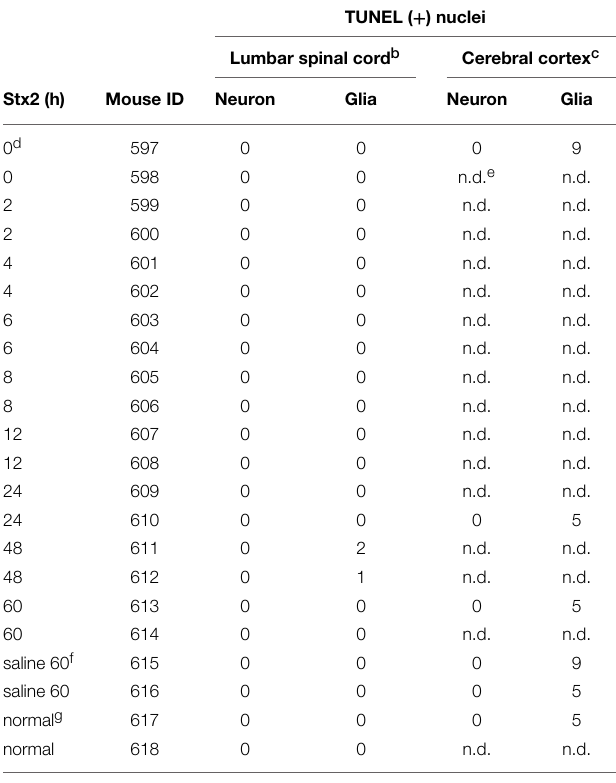
general numbers of neurons (data not shown). In vivo , astrocytic TABLE 1 | TUNEL results in spinal cord and cortex of Stx2-injected mice a . TUNEL ( + ) nuclei